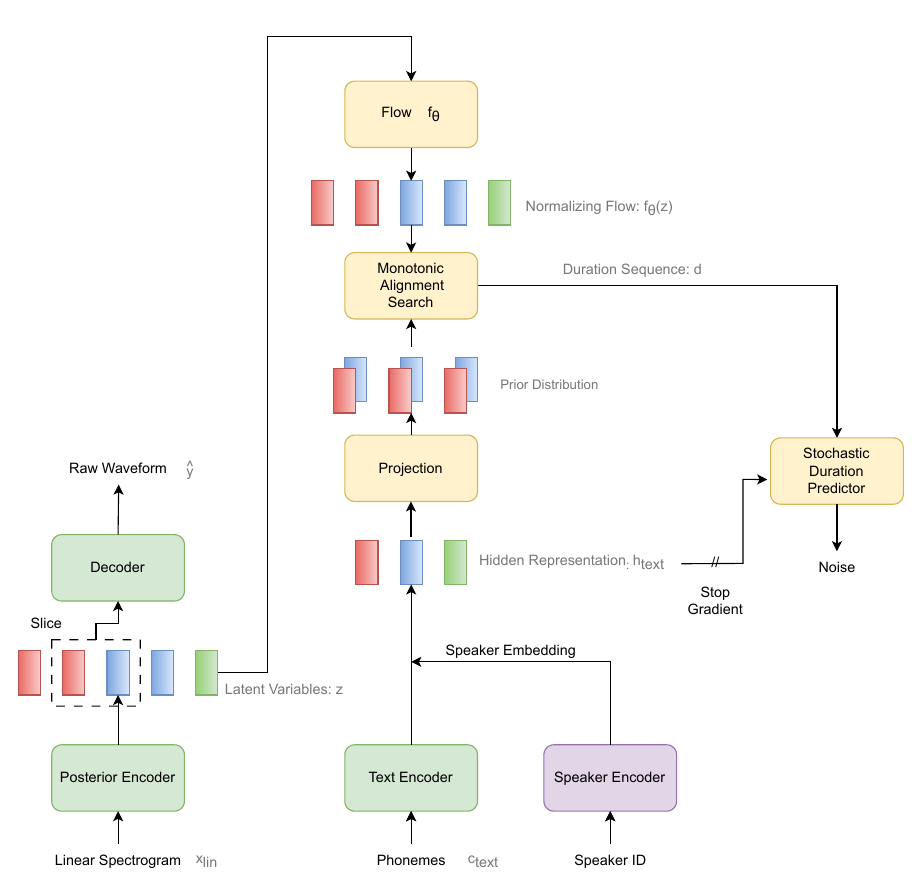
Figure 5. The structure of the VITS model. We implemented the multi-speaker VITS by adding the speaker encoder